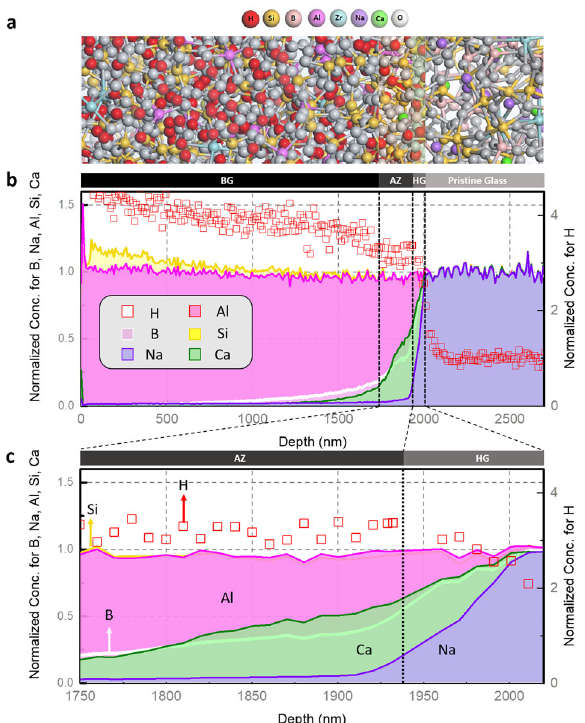
Fig. 2 Identi fi cation of the various sublayers within the gel: hydrated glass (HG), active zone (AZ), bulk gel (BG). For glass cations i, intensities are normalized to that of Zr, an immobile element, and the resulting ratio is normalized to the mean value of i/ Zr in the pristine glass. For H, intensities are normalized to the mean value in the pristine glass. Therefore data for glass cations are quantitative whereas they are only qualitative for H. a Snapshot of the various layers characterized by their compositions from ISG structural model generated from molecular dynamics simulations 32 . b Elemental pro fi les obtained for the sample pH 7 - 2312 days. c Zoomed-in view of the interfacial area with details of the HG and AZ. The interfacial gradient can result from either a real chemical gradient or a rough interface 30,40,41 .